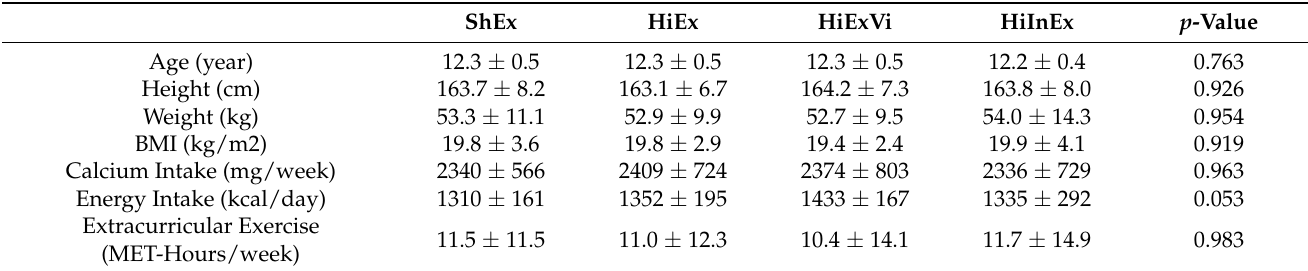
Table 1. Characteristics of participants between groups (mean ± SD).